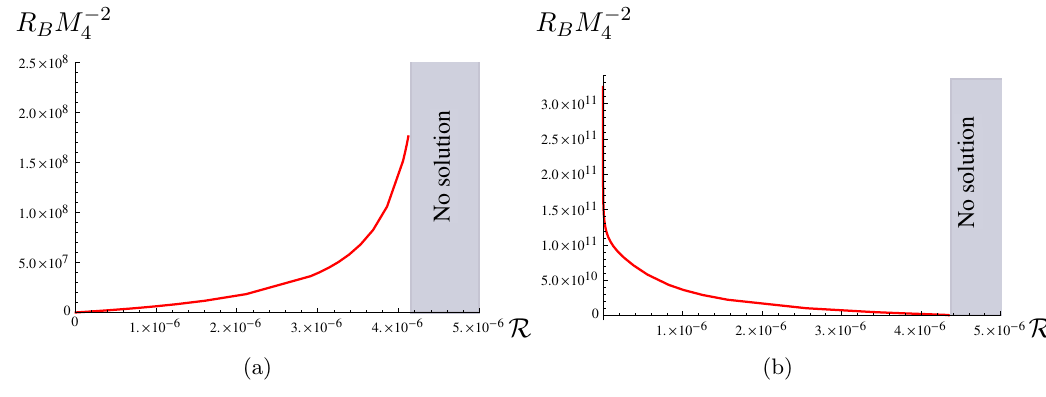
p vs. R for b = 0 : 9 (cid:2) 2 = 3. Results are obtained for bulk 4